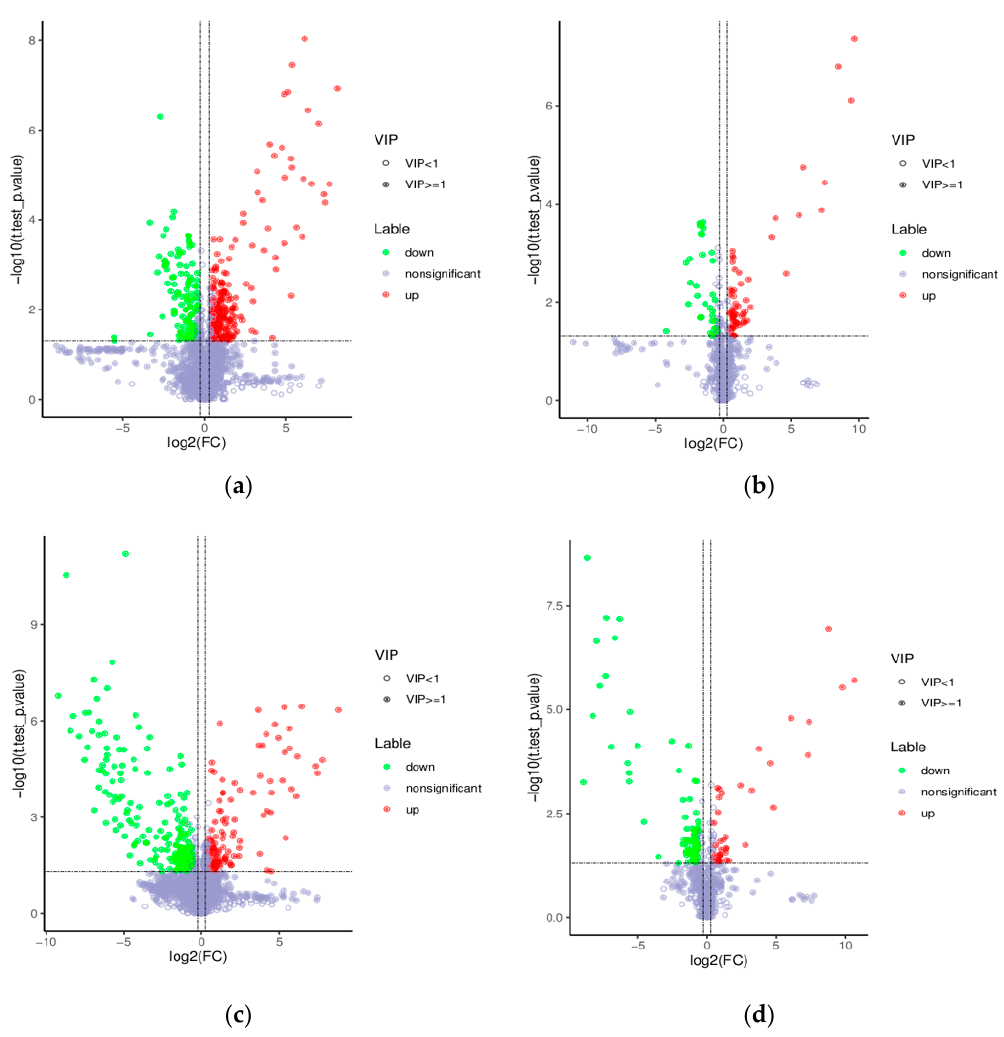
Figure 9. Volcano map of di ff erential metabolites. ( a ) Positive ion mode (WOPs-HG group vs. model group); ( b ) negative ion mode (WOPs-HG group vs. model group); ( c ) positive ion mode (WOPs-HG group vs. omeprazole group); ( d ) negative ion mode (WOPs-HG group vs. omeprazole group). Green is the downregulated di ff erential metabolite (labeled green), red is the upregulated di ff erential metabolite (labeled red), and metabolites without di ff erence are labeled with purple-gray.